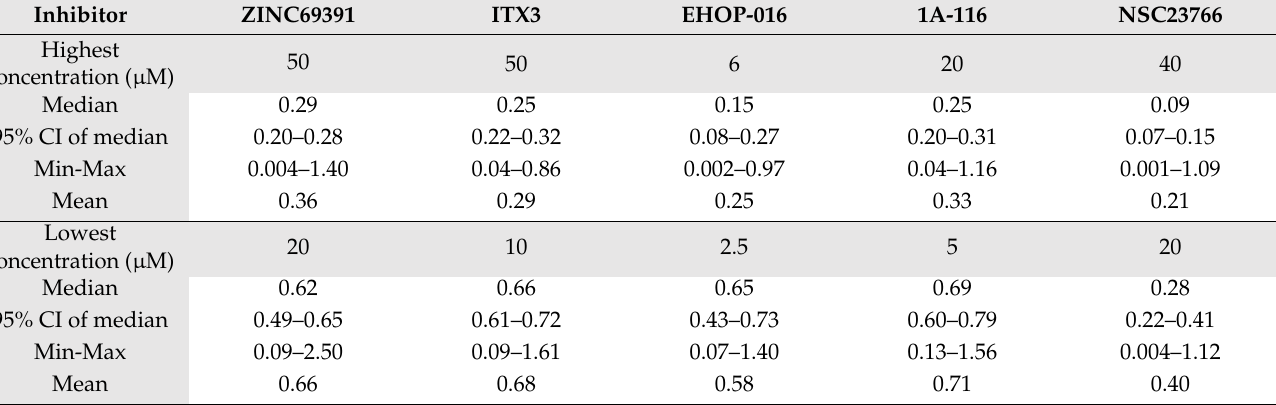
Figure 2. Results of 3 H-Thymidine proliferation assay after seven days of culture. ( A – E ): Dose- response curves for each of the five Rac1 inhibitors. The x-axis shows the inhibitor concentration in µ M, in log-scale starting at 0.4 µ M (except for ( B ) starting at 1 µ M). The y-axis represents proliferation as a percent of the untreated control set to 100%. The curves (non-linear fit) are plotted with median values (black dots) and 95% CI as an error. Calculated IC 50 values and 95% CI error for each compound are as follows: ZINC69391 23 µ M (15–29 µ M), ITX3 24 µ M (15–40 µ M), EHOP-016 3 µ M (1.8–3.9 µ M), 1A-116 10 µ M. (8–11 µ M), and NSC23766 12 µ M (9–15 µ M). ( F – J ): Proliferation is presented as a ratio to the untreated control (set to 1, dotted line). Each inhibitor is tested at two concentrations for all patient samples, aiming for ratios of 0.60 and 0.20 (lowest and highest concentration, respectively). Results are given as a box plot with whiskers for 2.5 and 97.5 percentiles. Each dot corresponds to an individual patient sample, showing the heterogeneity of the sensitivity toward the compounds. Table 3. Tabular view of the proliferation assay. The median proliferation determined by the 3 H- Thymidine assay of 63 patient-derived samples was assessed as a ratio to the untreated control set to 1. We anticipated that the highest concentration would result in a ratio of approximately 0.20 and the lowest concentration in a ratio of approximately 0.60. The actual median is presented in the table, with 95% CI as an error. Range from minimum to maximum proliferation, as well as mean values, are